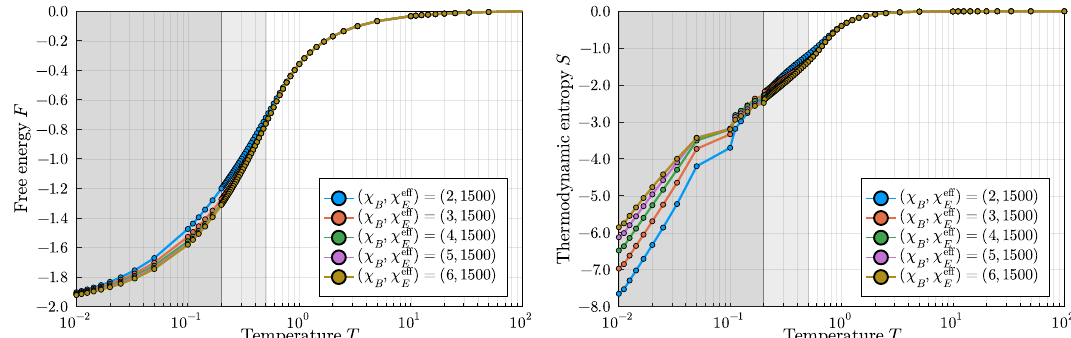
Figure 3: Free energy F and thermodynamic entropy S per site for the two- dimensional classical Heisenberg model on a square lattice. Both quantities are di- rectly computed from the tensor network construction approximating the partition function according to Eq.